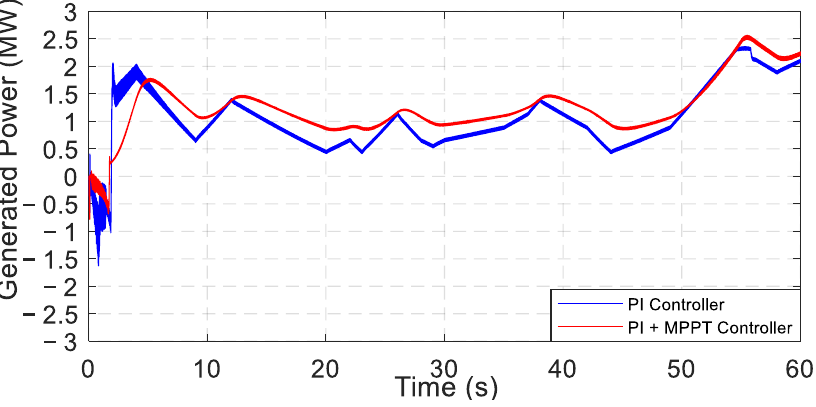
Figure 13. Generated power of the DFIG.